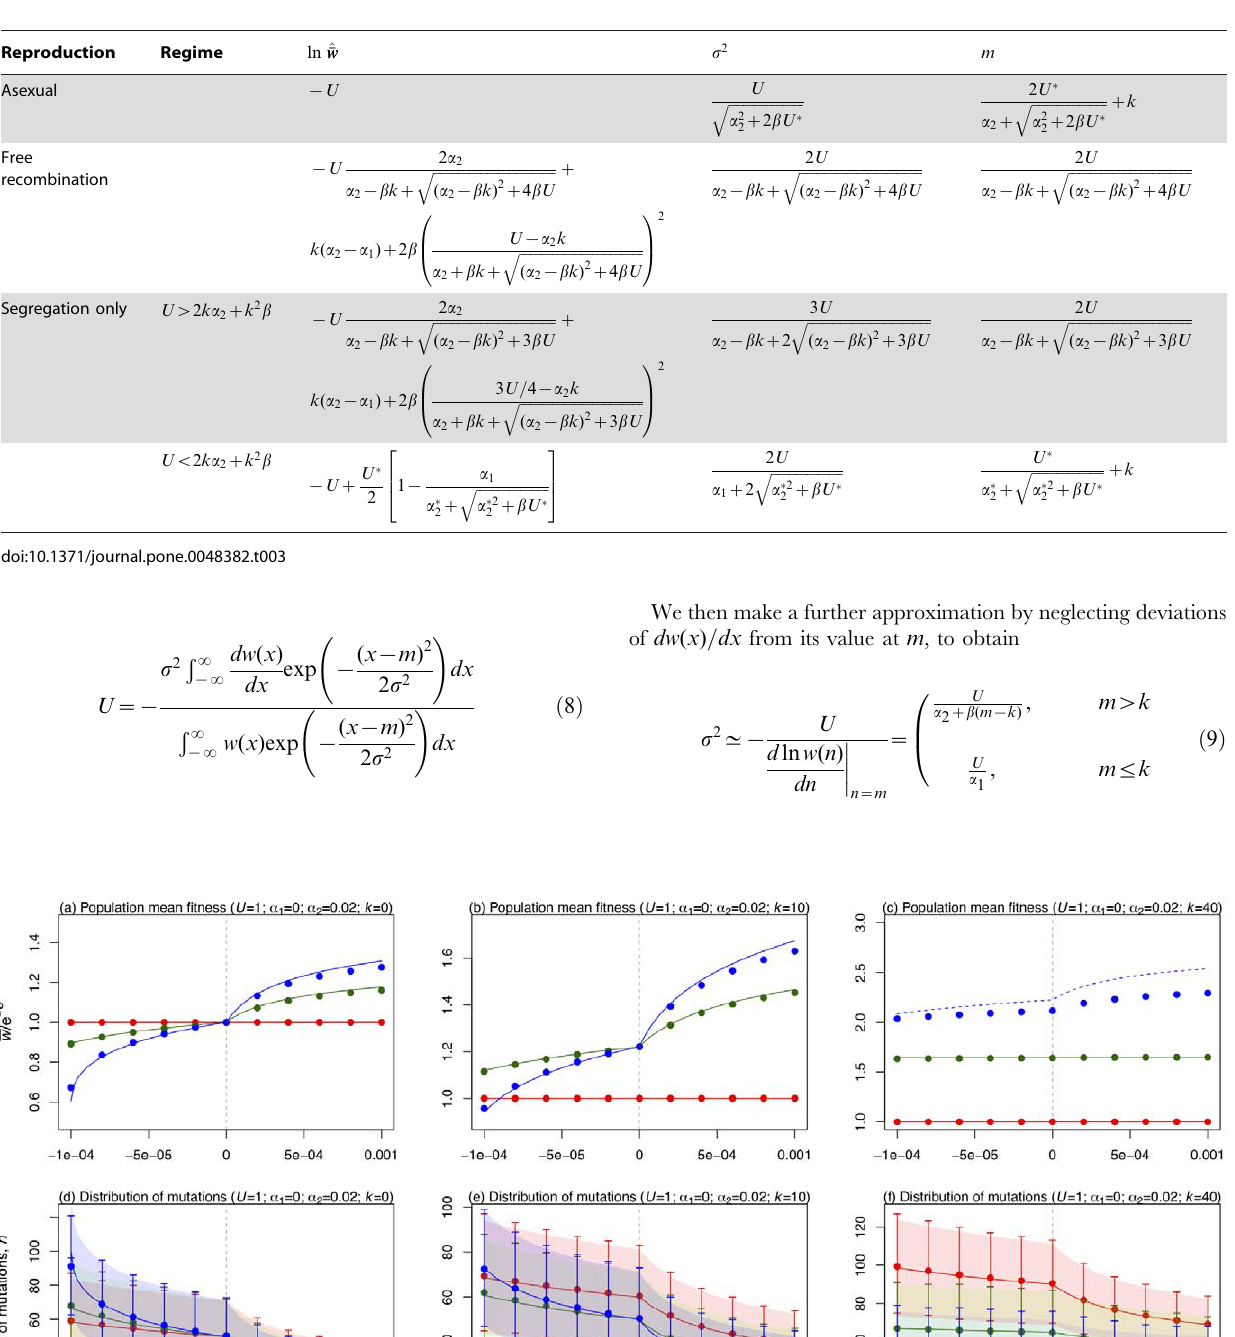
Table 3. Hidden epistasis for a generalized fitness function.